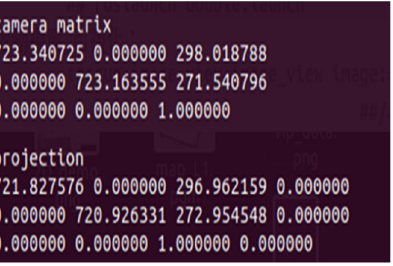
Figure 9. C525 Internal parameters and projection matrix.